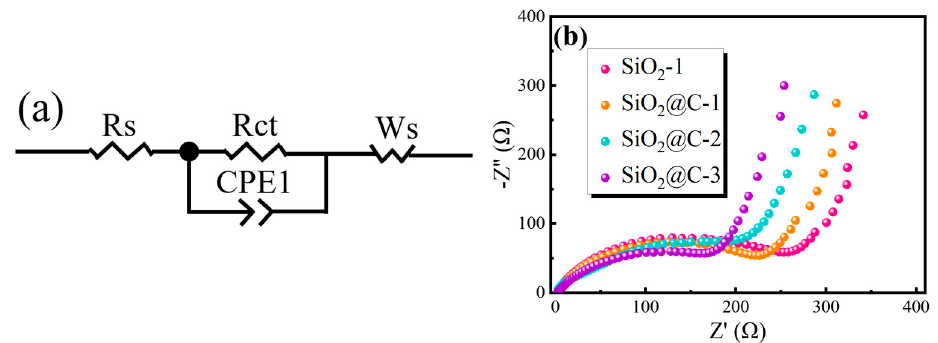
Figure 7. SiO 2 and SiO 2 @C composites: ( a ) equivalent circuit, ( b ) Nyquist plots.